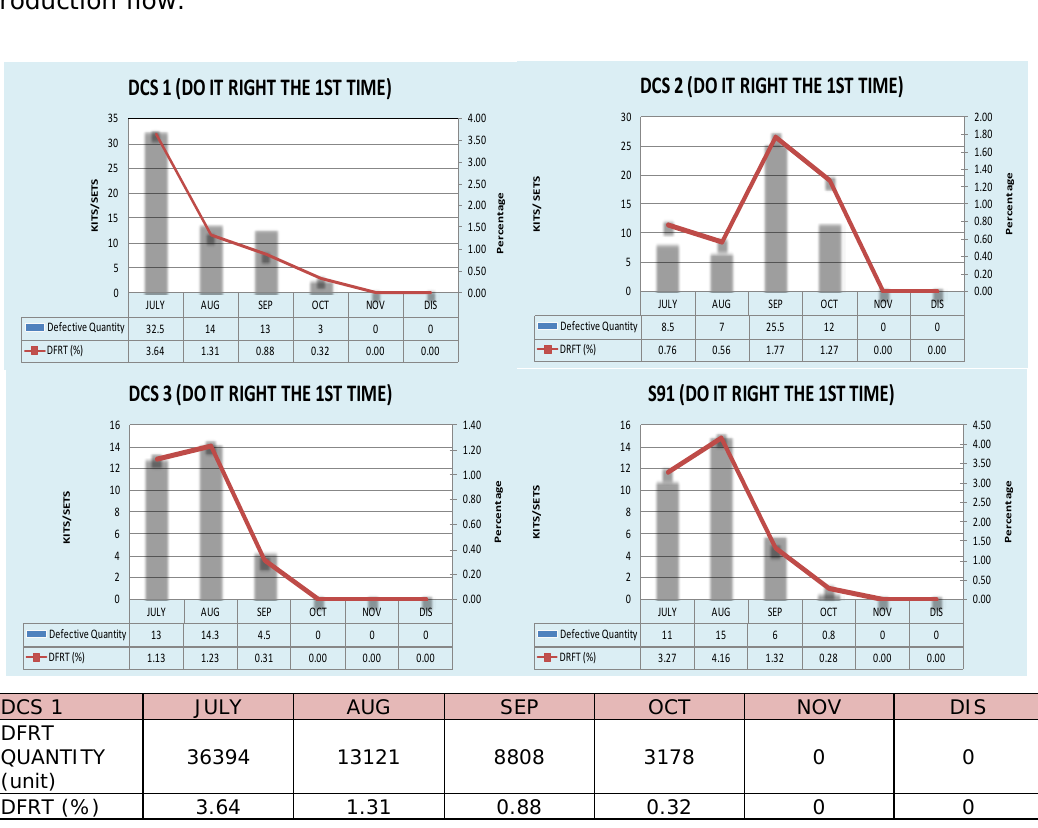
Figure 15. “Relationship of DRFT with product